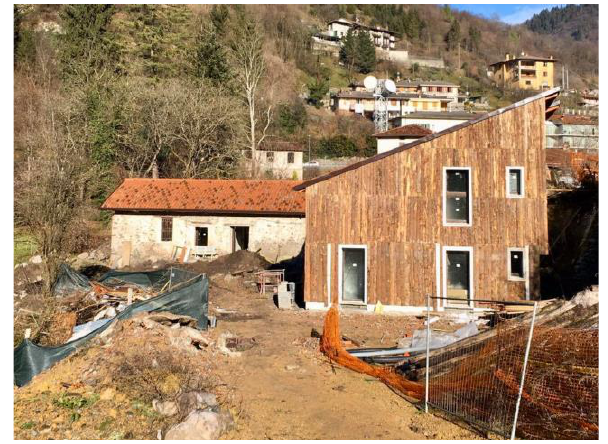
Figure 12. The masonry is covered in wood ‘peels’.